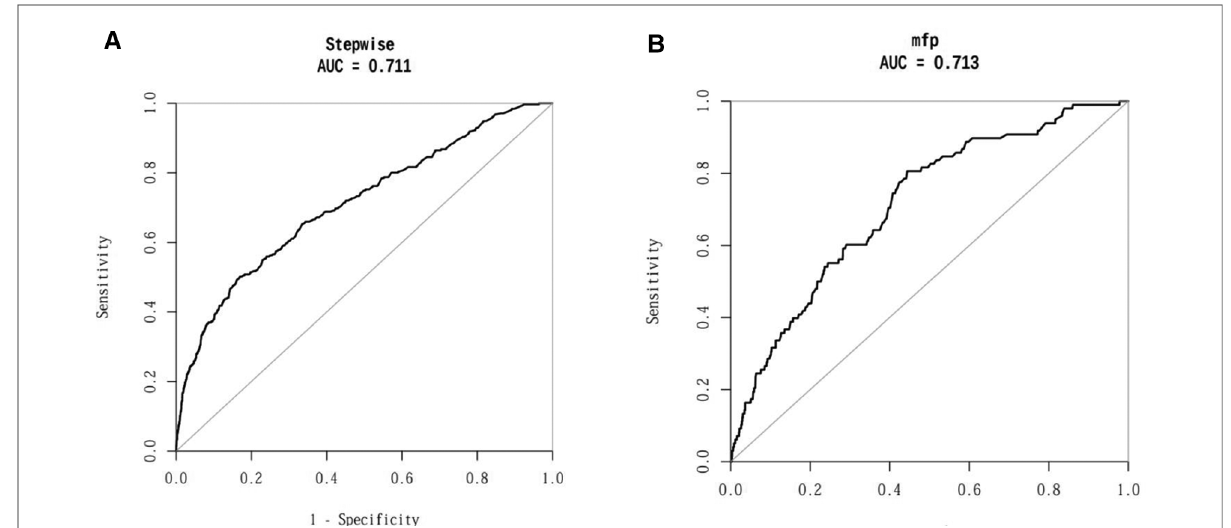
FIGURE 3 ROC curves of the prediction model for the column line graph of elderly patients with NSCLC. ( A ) AUC of the modelling group; ( B ) AUC of the validation